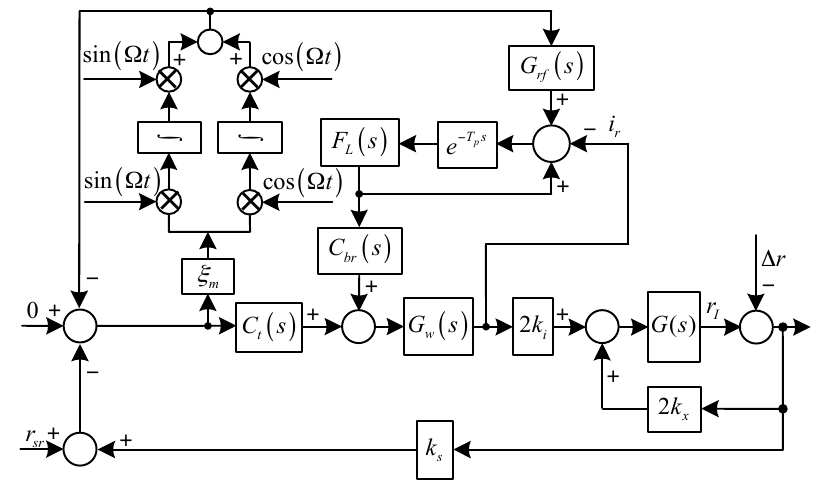
Figure 5. Diagram of the translational system with harmonic force elimination.